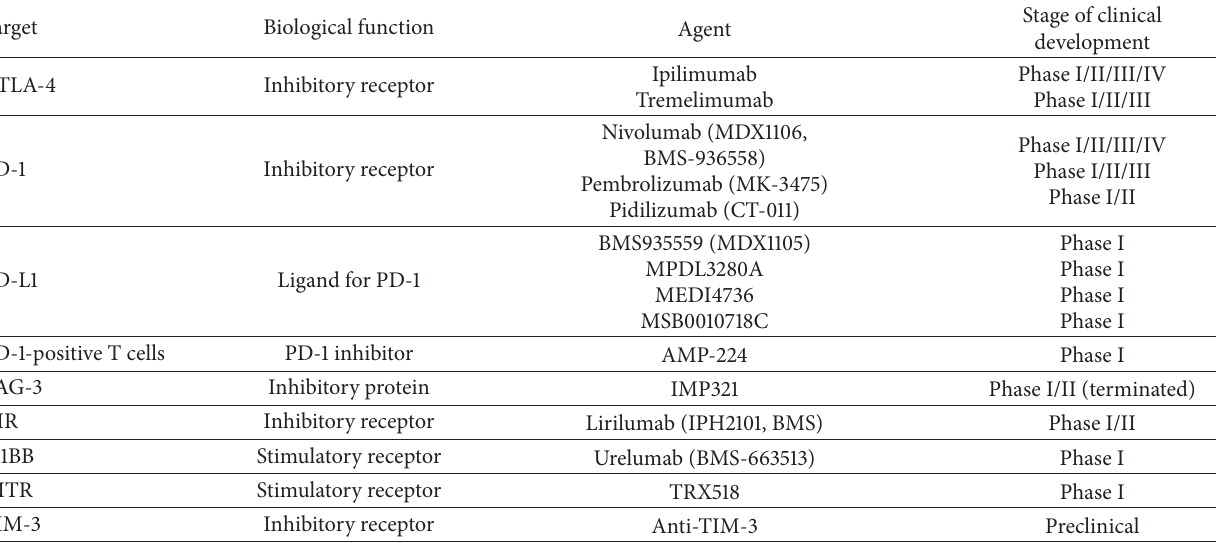
Table 1: Immune checkpoint antibodies under clinical development.